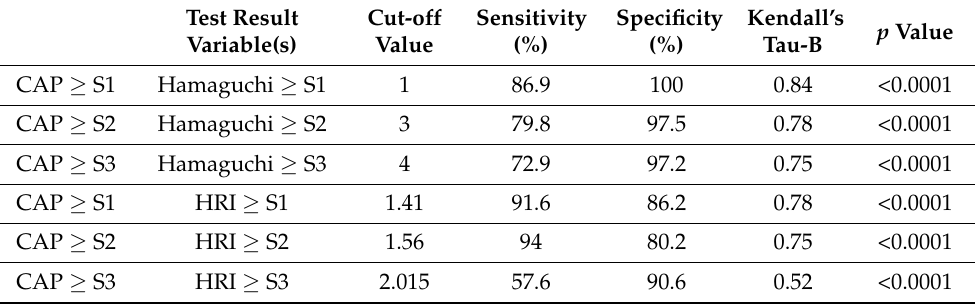
Figure 2. Correlation between controlled attenuation parameter (CAP) and non-invasive measures of steatosis. Correlations between liver steatosis diagnostic methods according to CAP and the hepatorenal index (HRI) ( A ), Hamaguchi’s score ( B ), fatty liver index (FLI) ( C ), hepatic steatosis index (HSI), ( D ) and lipid accumulation product (LAP) ( E ). Pearson’s coefficient ( ρ ) was used to evaluate the association between two continuous variables. Table 3. Diagnostic accuracy of the new optimal thresholds of Hamaguchi’s score and HRI for grading of hepatic Table 2. Diagnostic accuracy of Hamaguchi’s score, HRI, FLI, HSI, and LAP for the detection of hepatic steatosis.